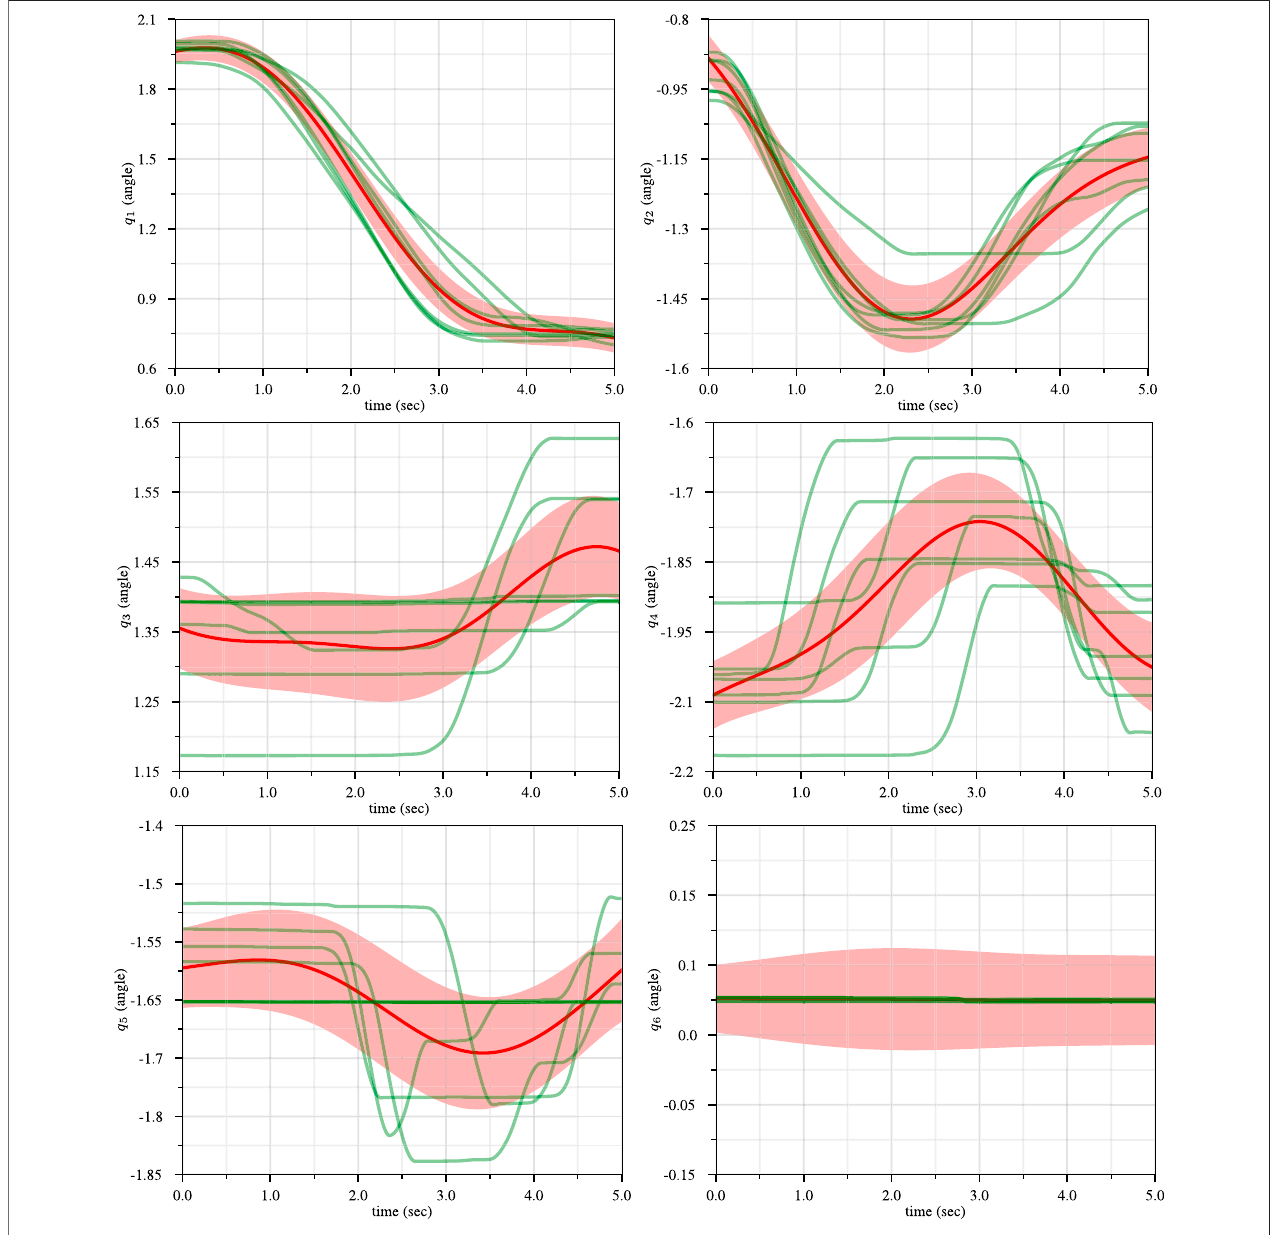
FIGURE 12 | The UR5e robot joint trajectories recorded from the human demonstration of the pick-and-place task are shown in green, while the ProMP mean trajectory and one standard deviation of the ProMP are colored red and light red, respectively.